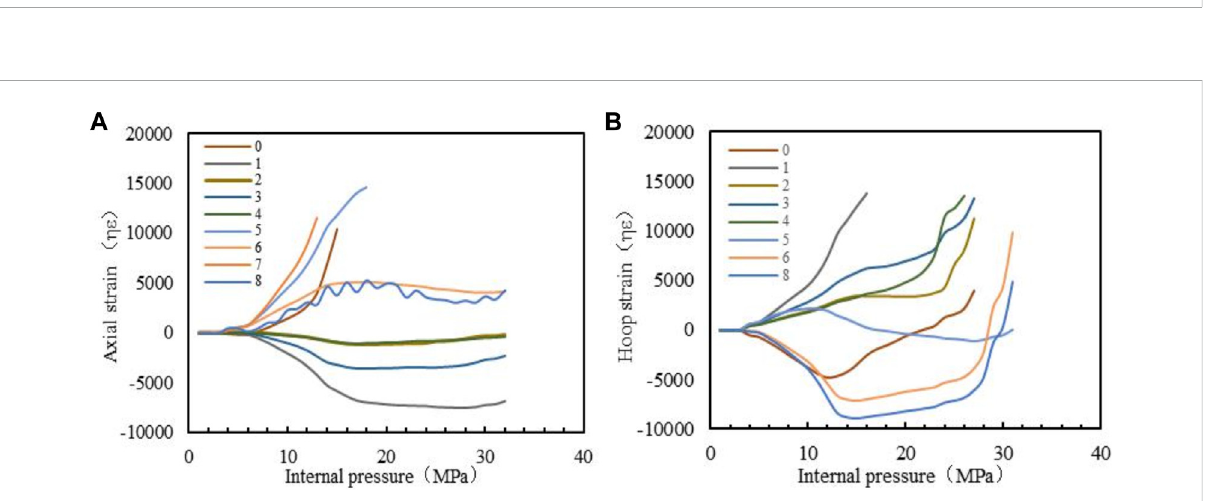
FIGURE 6 The pressure-straincurves for Sample #1, where (A) shows the pressure-axial strain curves, and (B) shows the pressure-circumferentialstrain